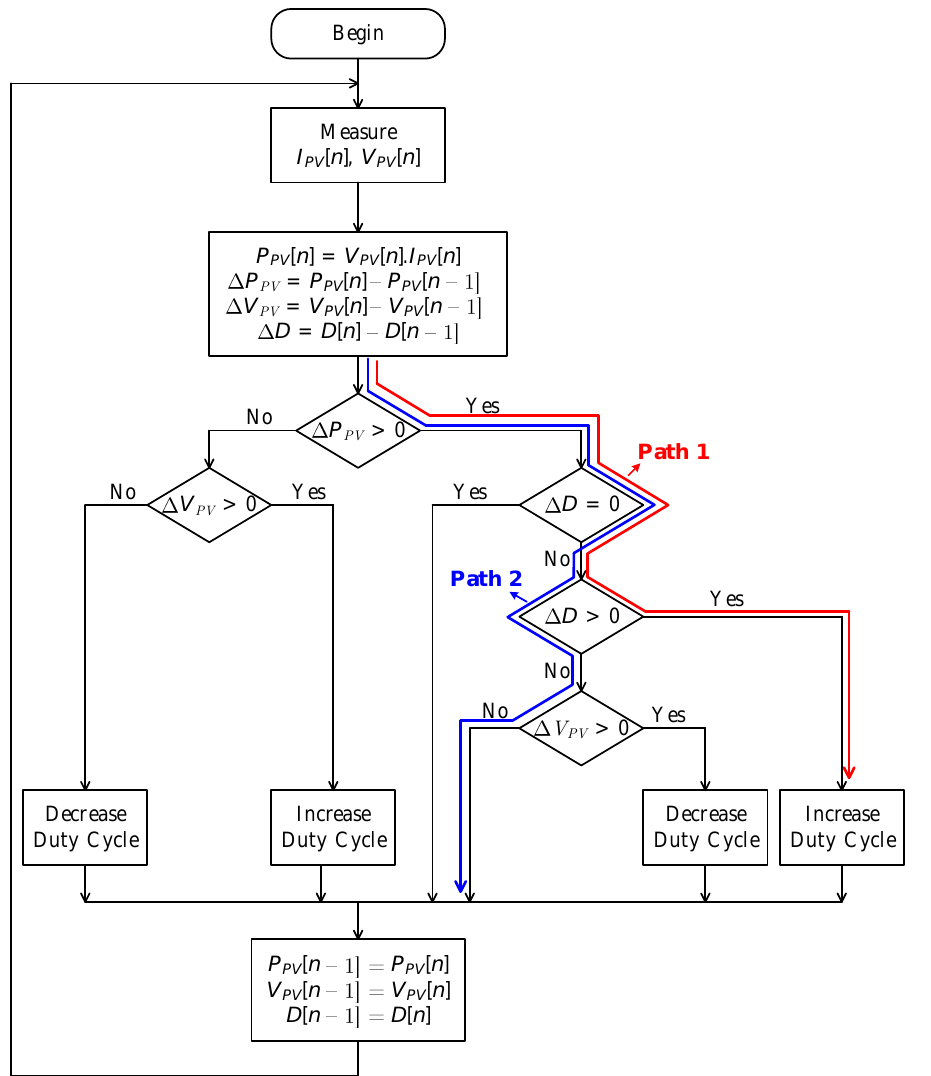
Figure 13. Responses of the proposed algorithm when solar radiation is unchanged: Path 1 or Path